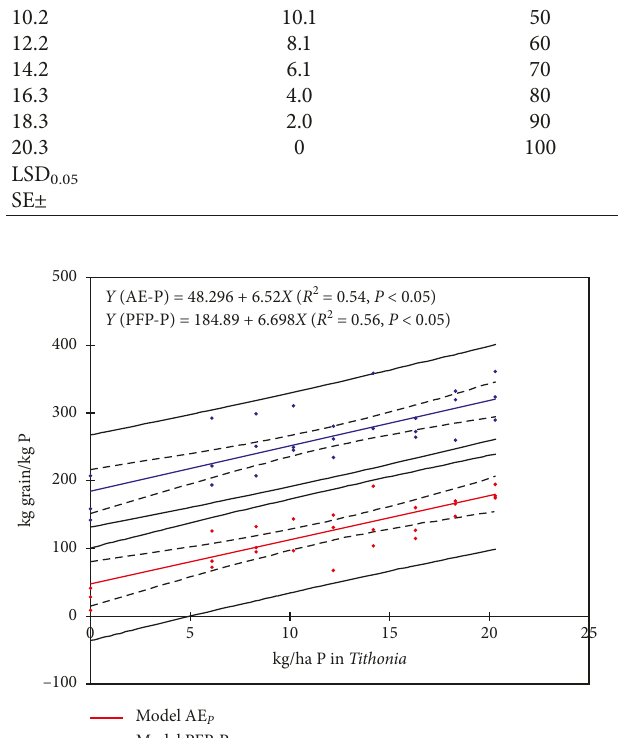
Figure 2: Effect of P supplied to maize through Tithonia biomass on agronomic nutrient use efficiency (AE) and partial factor productivity (PFP) of phosphorus.